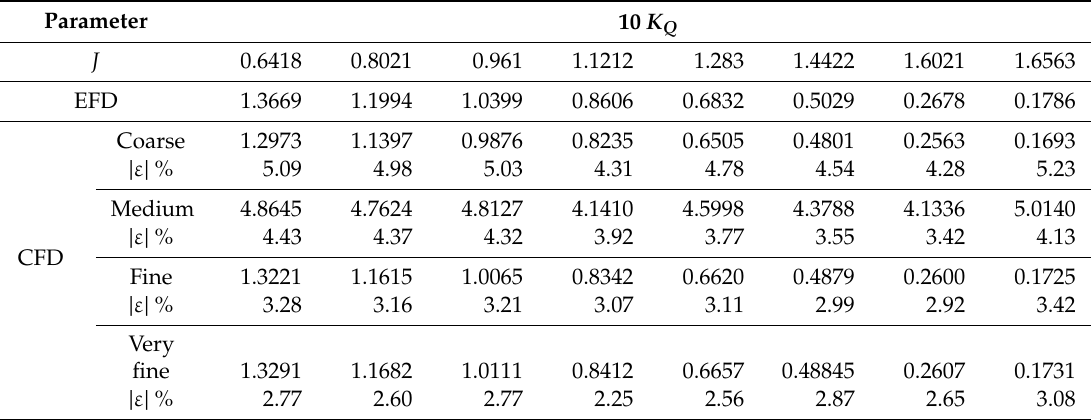
Table 4. Grid convergence test for the torque coe ffi cient. Wetted propeller